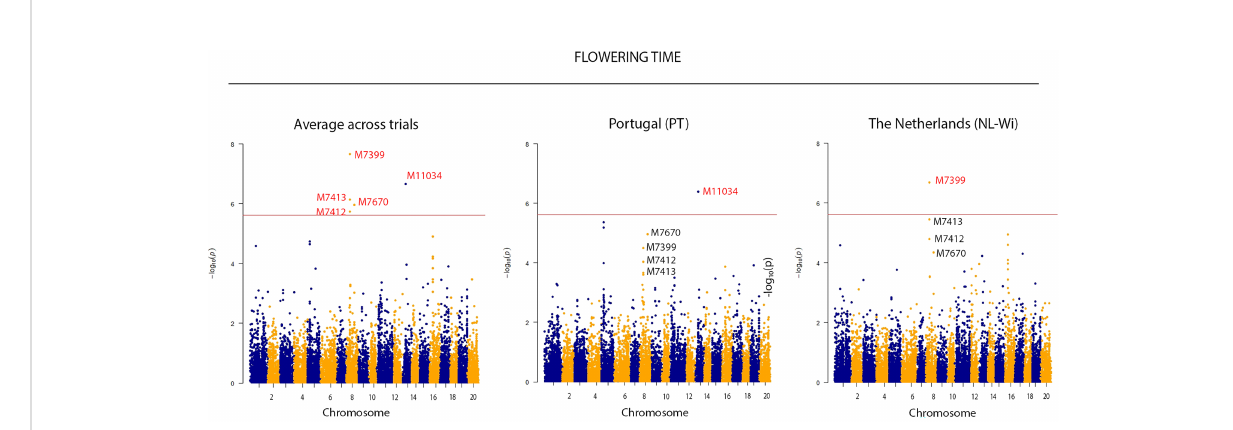
FIGURE 3 Manhattan plots displaying SNP markers-trait associations identi fi ed for Flowering time in GWAS using 223 accessions of L. mutabilis . The red line indicates the Bonferroni threshold (LOD = 5.52). Common SNPs showed signi fi cant association with variation in fl owering time across locations, even if not all of them were detected as signi fi cant.